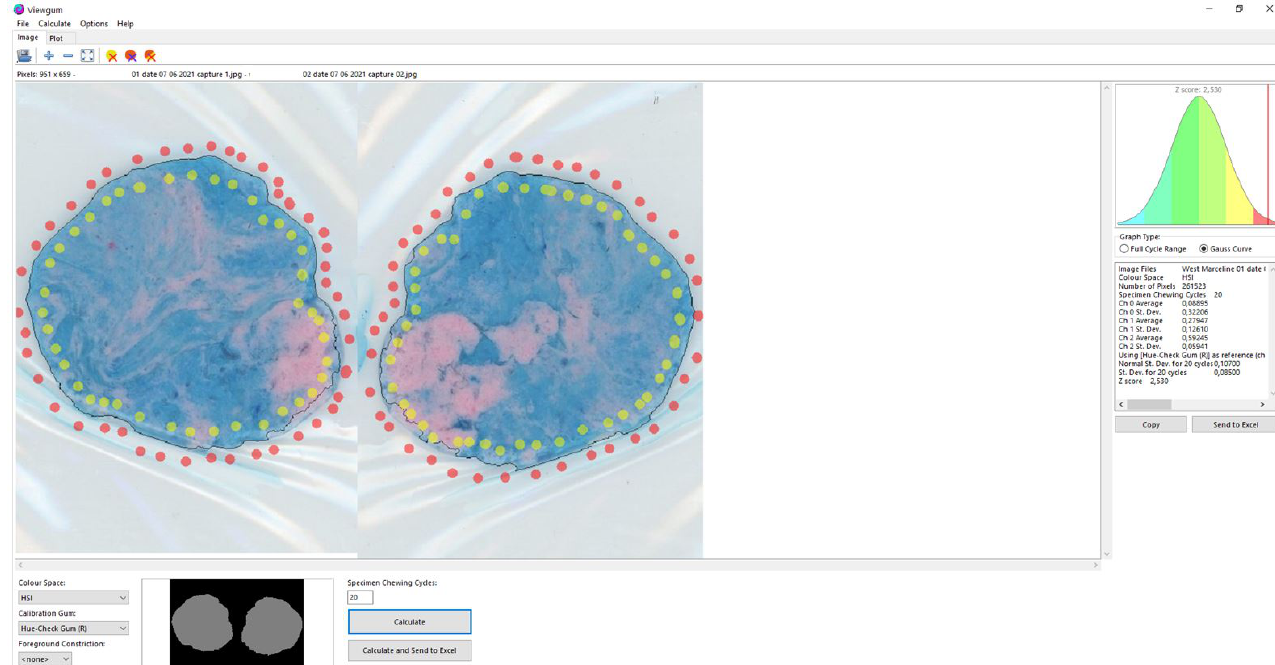
Figure 2. Analysis of flattened two-color chewing gum with ViewGum software (dHAL Software, Kifissia, Greece, http://www.dhal.com/viewgum.htm (accessed on 25 October 2021)) after performing the Hue-check View Gum ® Test (Orophys, Bern,